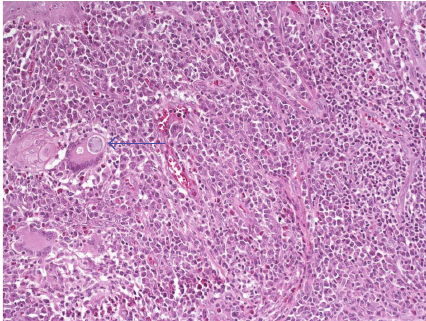
Figure 3: Chronic granulomatous inflammatory infiltrate, showing lymphocytes, plasma cells, and multinucleated giant cells containing spherical cytoplasmic inclusions corresponding to Coccidioides immitis (H&E; 200x).